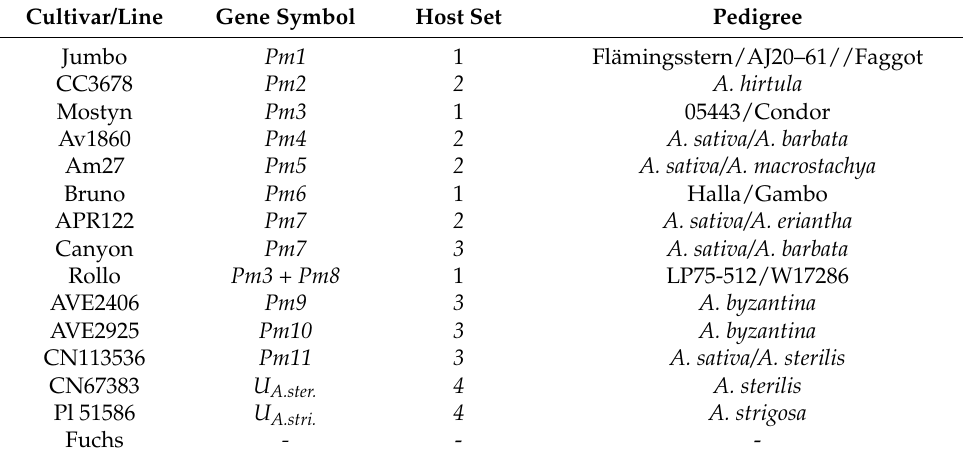
Table 1. Standard differential set of oat lines and cultivars with known resistance genes used to characterize virulence structure of the Blumeria graminis populations on oat in Poland across 2016 – 2019 [16,18 – 21].